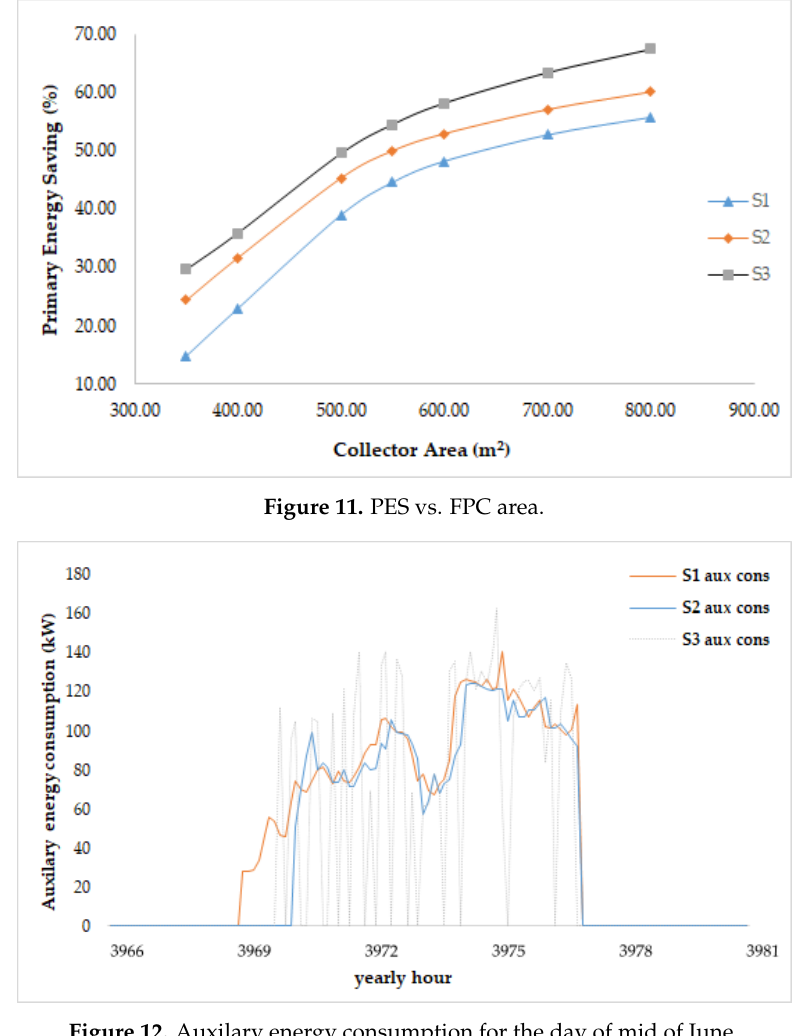
Figure 12. Auxilary energy consumption for the day of mid of June.